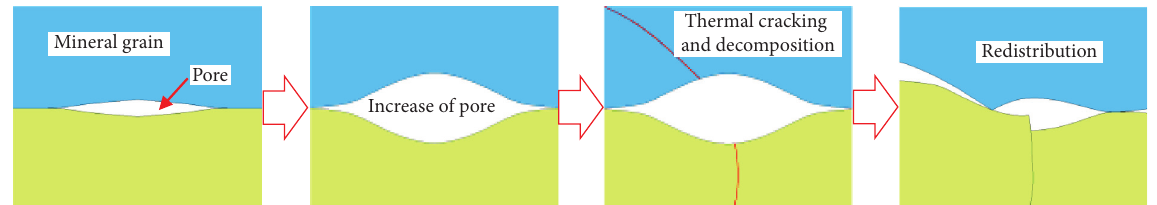
Figure 13: Evolution process of microscopic structure of limestone with the increasing temperature.